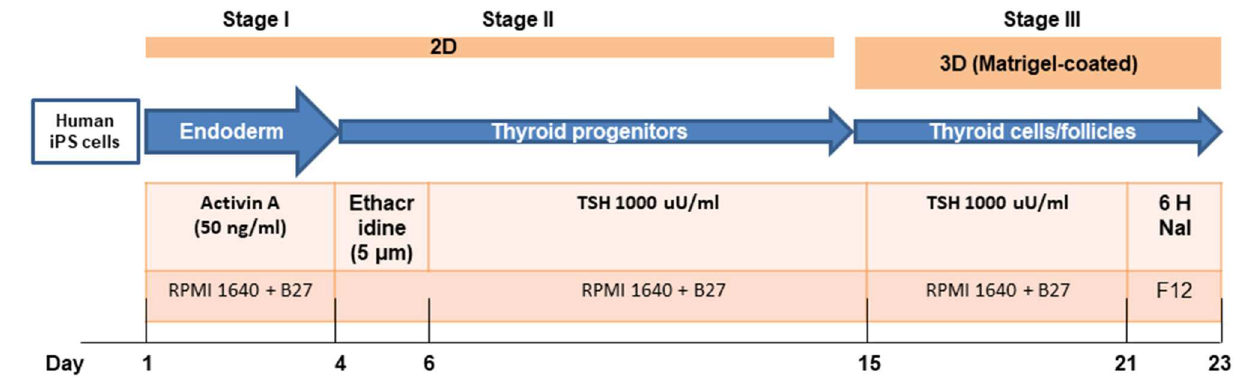
FIGURE 1 | A sequential treatment scheme for differentiation of thyroid cells from human iPSCs (LF